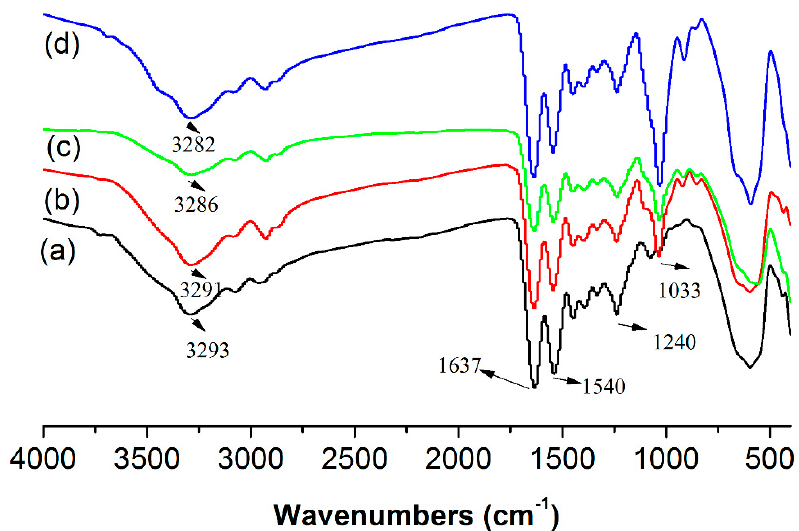
Figure 5. ATR-FTIR spectra of ( a ) pure FG, ( b ) FG/GE30, ( c ) FG/GE30/HTs4 and ( d ) FG/GE30/HTs10.